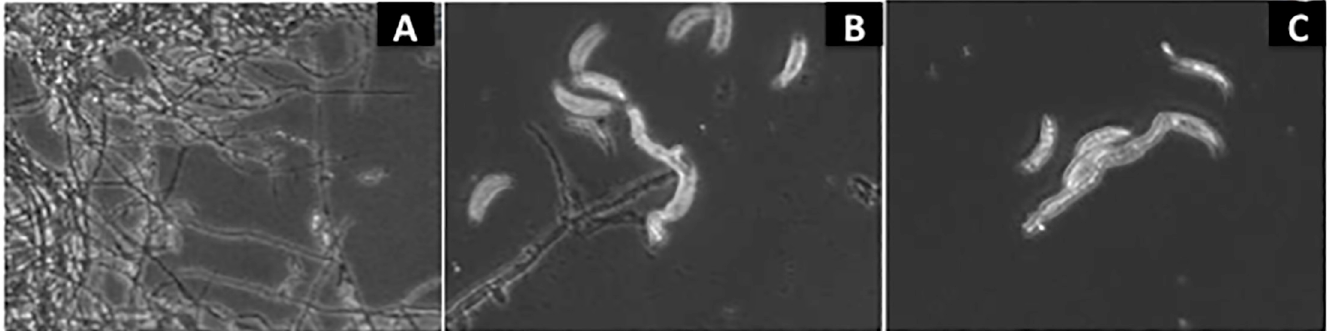
Fig 3. Phase contrast micrograph images showing vegetative growth and hyphael morphology of C . graminicola following incubation with kochia extracts. (A) untreated, 25˚C, 72 h, (B) 25 mg mL -1 , 25˚C, 72 h, and (C) 50 mg mL -1 , 25˚C, 24 h.